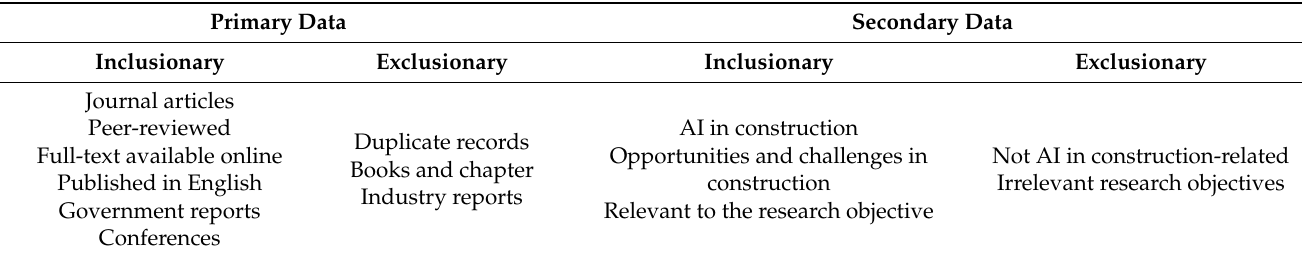
Table 2. Exclusion and inclusion criteria, derived from [44].